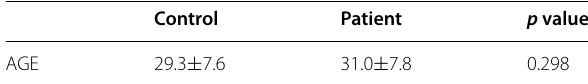
Table 1 Average age of the groups